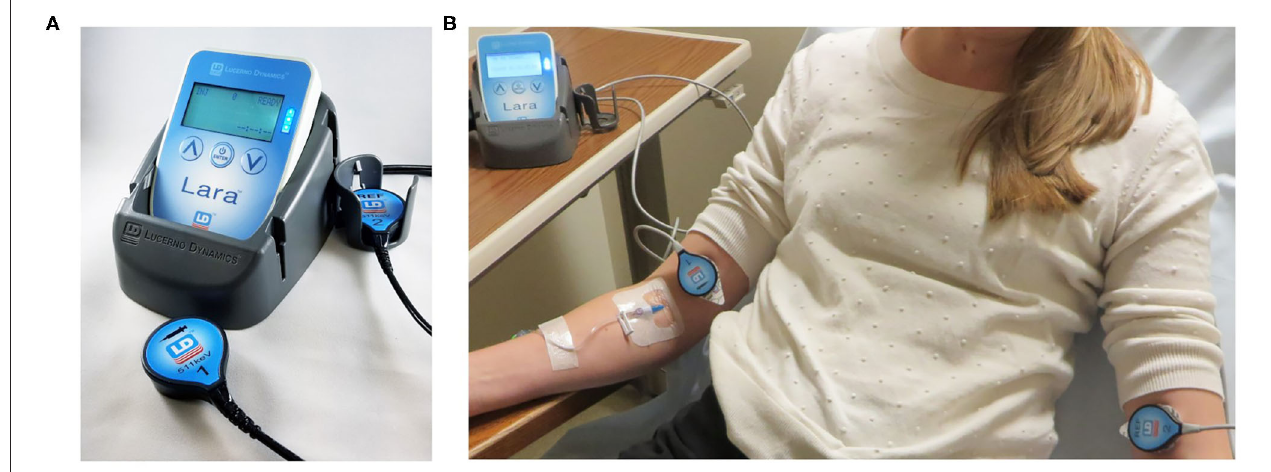
FIGURE 1 | Lara device consists of 2 scintillation sensors, a reader, and a docking station (A) . Sensors placed on injection arm and reference arm (B)